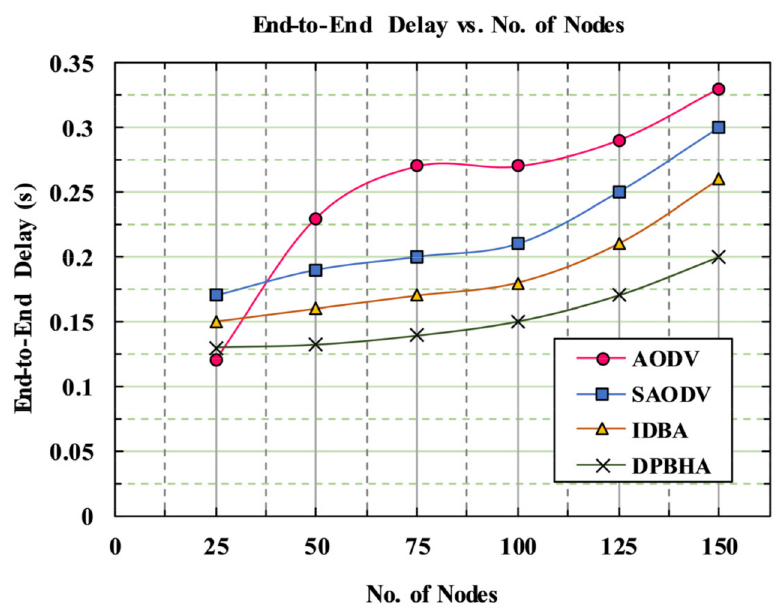
Figure 13. Graphical representation of end-to-end